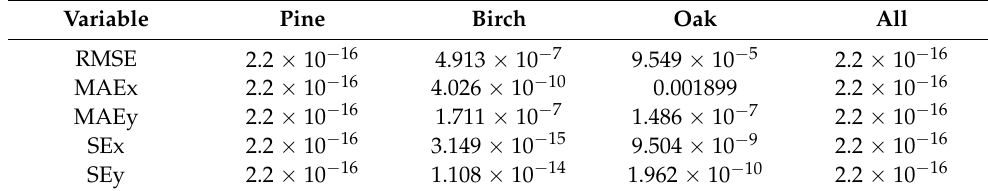
Table 3. Results of Shapiro–Wilk test (expressed in p -value) when checking the normal distribution of errors while taking into consideration the main tree